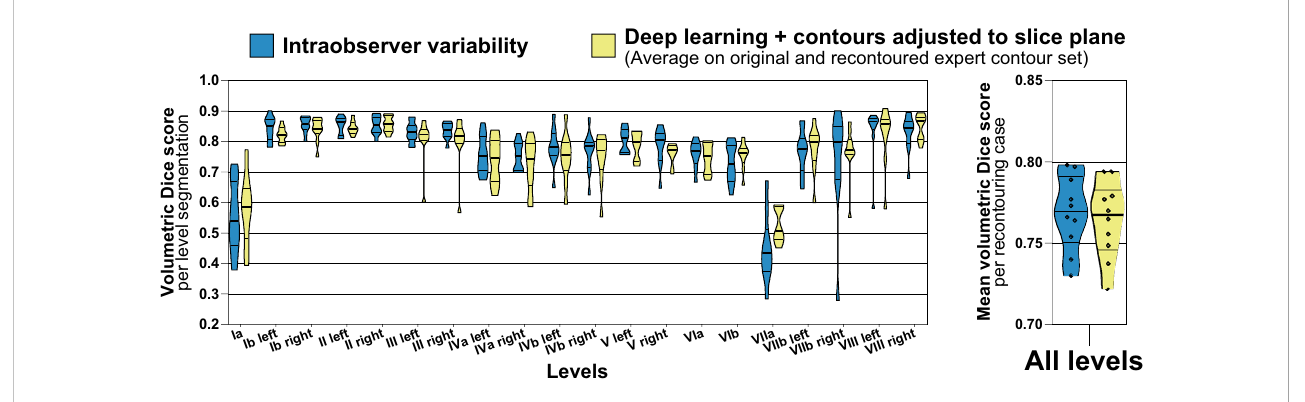
FIGURE 6 Accuracy (volumetric Dice score) of deep learning level autocontours (yellow) compared to intraobserver variability (blue). Intraobserver variability was determined by recontouring nodal levels in a subset of n = 10 randomly chosen test set cases after an interval of 3 months. Accuracy of deep learning autocontouring was calculated by averaging the achieved volumetric Dice scores on the original and recontoured set of expert contours. The left graph shows volumetric Dice scores for each level separately. The right graph shows mean volumetric Dice scores per recontouring case across all levels. Violin plots, thick horizontal lines: median, thin horizontal lines: quartiles, rhombi: individual data points.